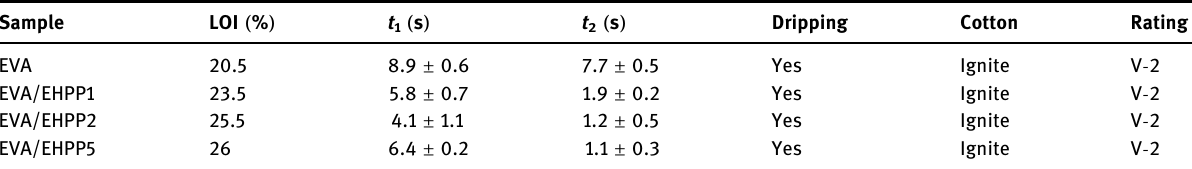
Table 3: Detailed data of LOI and UL - 94 vertical burning test